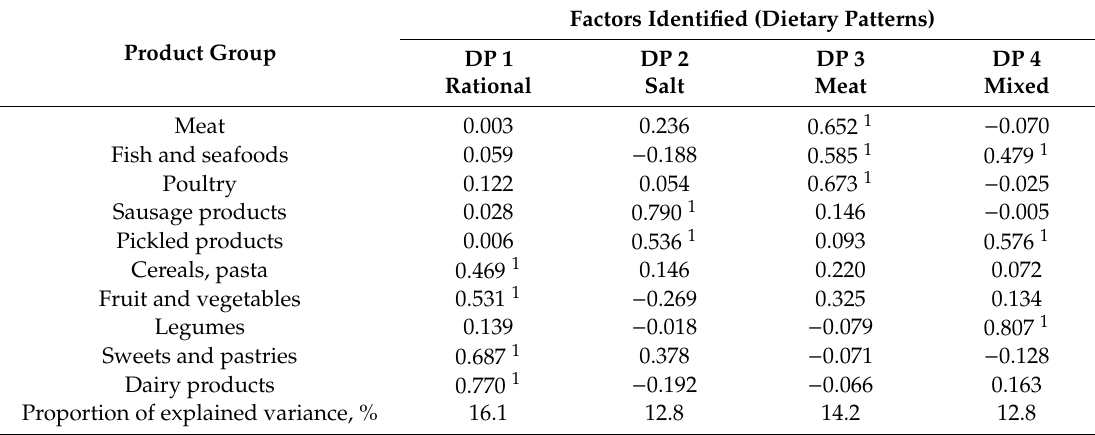
Table A2. Factor loadings of the principal dietary patterns identified (men).